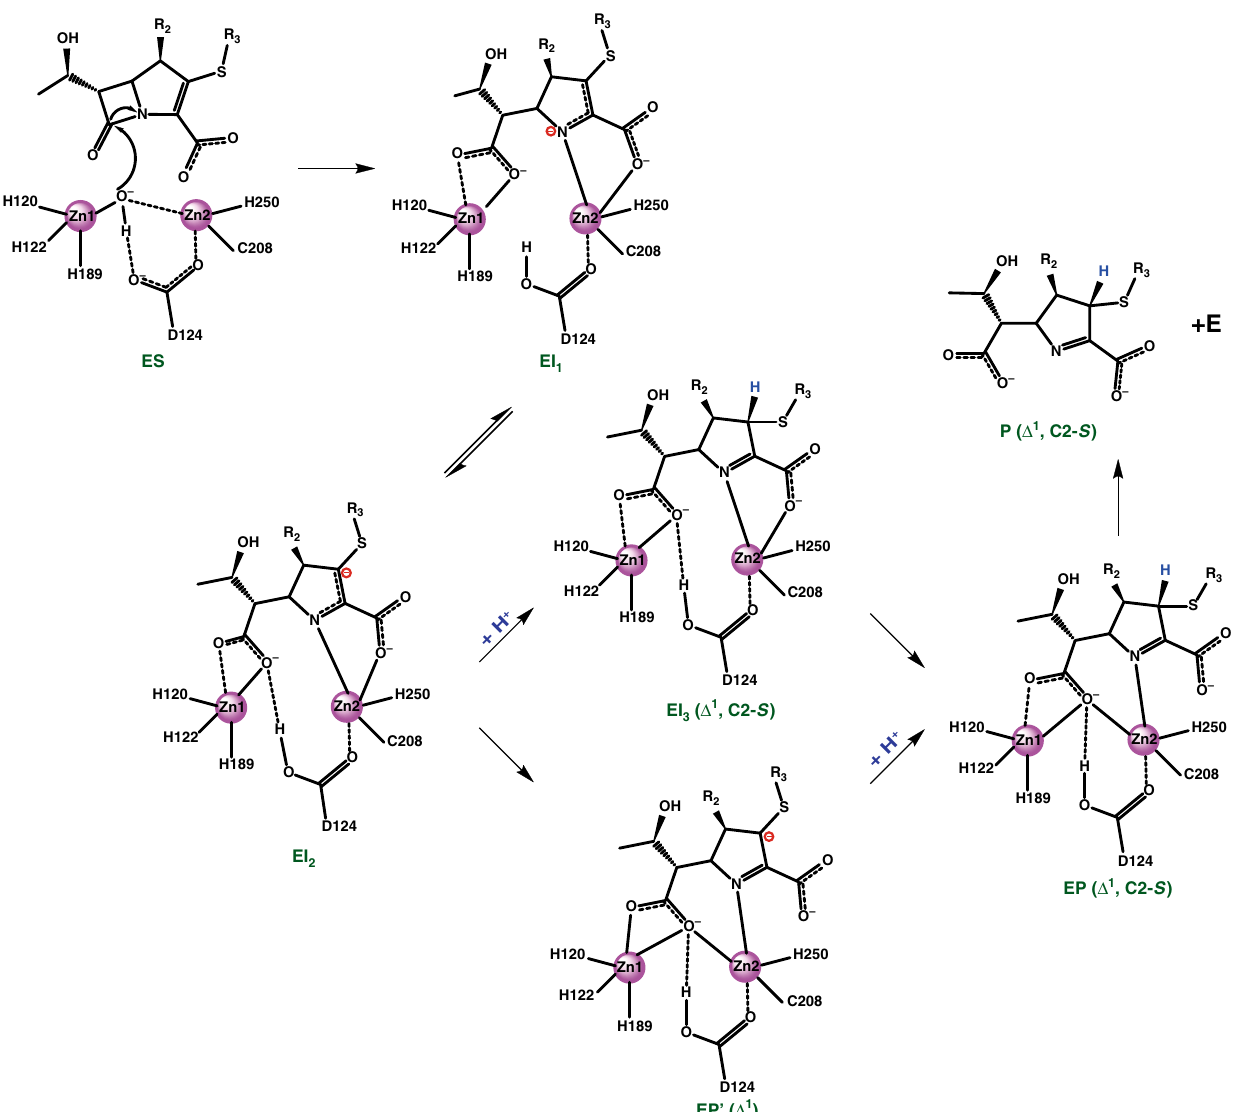
Fig. 5 Hypothesized reaction mechanism of carbapenem hydrolysis catalyzed by NDM-1. The EI 1 , EI 2 , and EP complexes are trapped in crystal structures and the β -diastereomeric product is detected by NMR. Two other possible intermediates, EI 3 and EP', are not experimentally characterized. The pink spheres represent zinc ions and the surrounding labels are zinc-coordinating